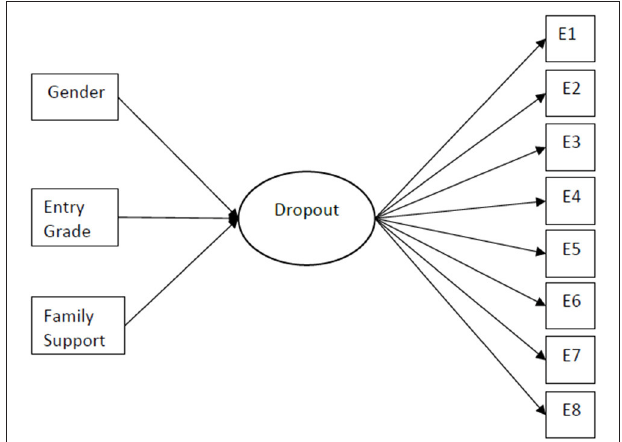
FIGURE 1 | A conditional model of dropout with time-invariant predictors. The 8 binary time-specific indicators correspond to the hazard probabilities of dropout across semesters.